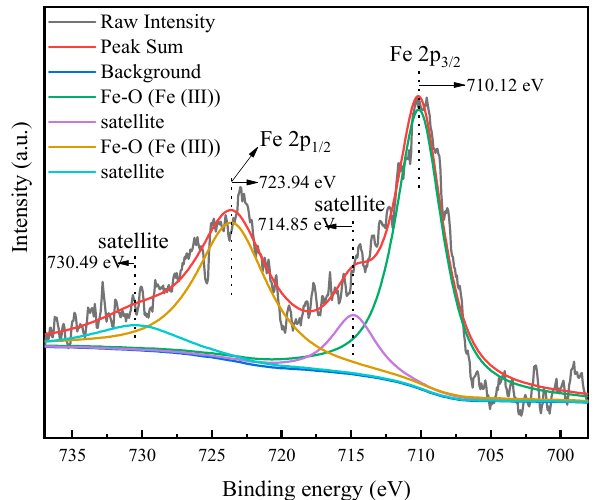
Figure 7. High-resolution XPS spectra of Fe 2p in modified rectorite.